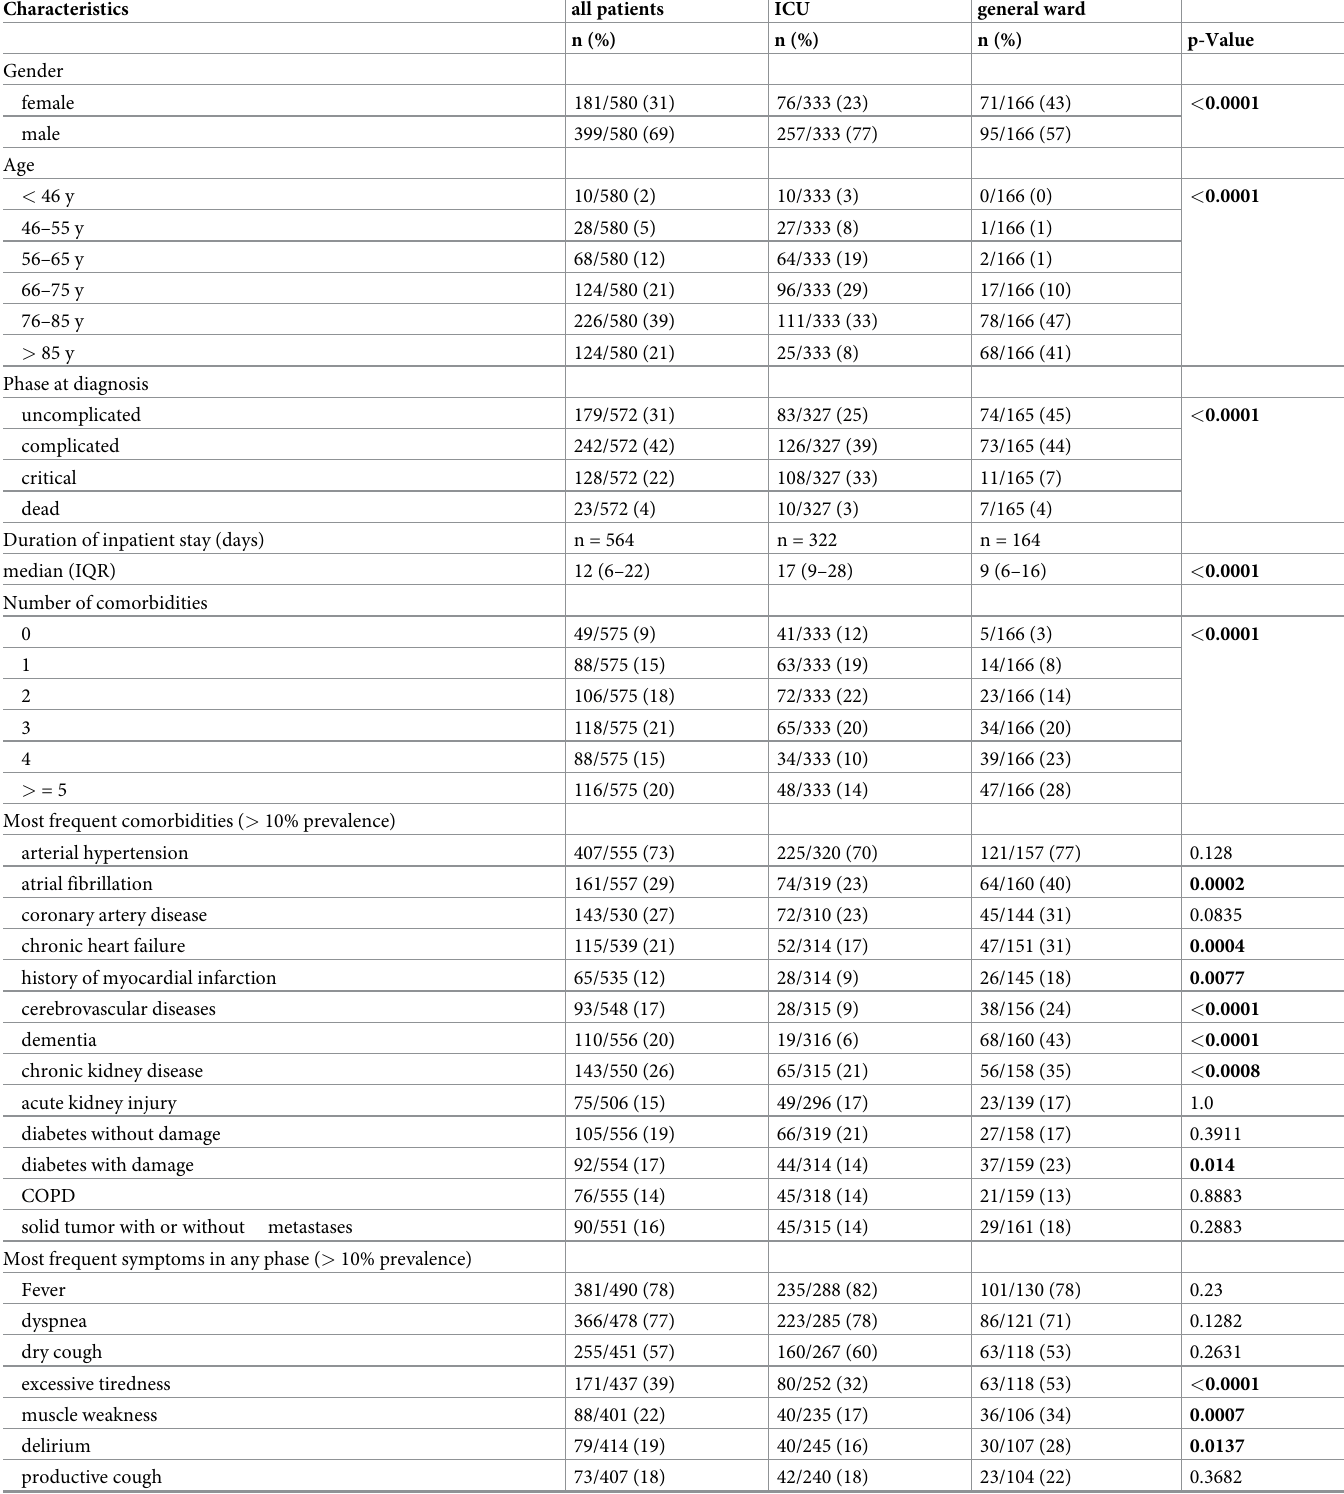
Table 1. Characteristics of patients dying with SARS-CoV-2 infection treated on ICU or general ward.